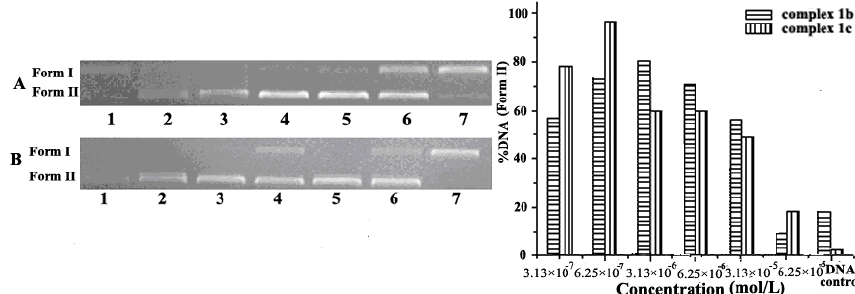
Figure 1. Histograms and electropherograms (the right side figure) representing cleavage of pUC19 plasmid DNA (0.008 µg/µL) by different concentrations of 1b (pH = 7.4) and 1c (pH = 7.4) in buffer (5 mM Tris-HCl/10 mM NaCl) at 37 °C for 6 h. ( A ) Complex 1b ; Lanes 1–6: 6.25 × 10 − 5 , 3.13 × 10 − 5 , 6.25 × 10 − 6 , 3.13 × 10 − 6 , 6.25 × 10 − 7 , 3.13 × 10 − 7 mol/L, Lane 7 = DNA control, respectively; ( B ) Complex 1c ; Lanes 1–6: 6.25 × 10 − 5 , 3.13 × 10 − 5 , 6.25 × 10 − 6 , 3.13 × 10 − 6 , 6.25 × 10 − 7 , 3.13 × 10 − 7 mol/L, Lane 7 = DNA control, respectively